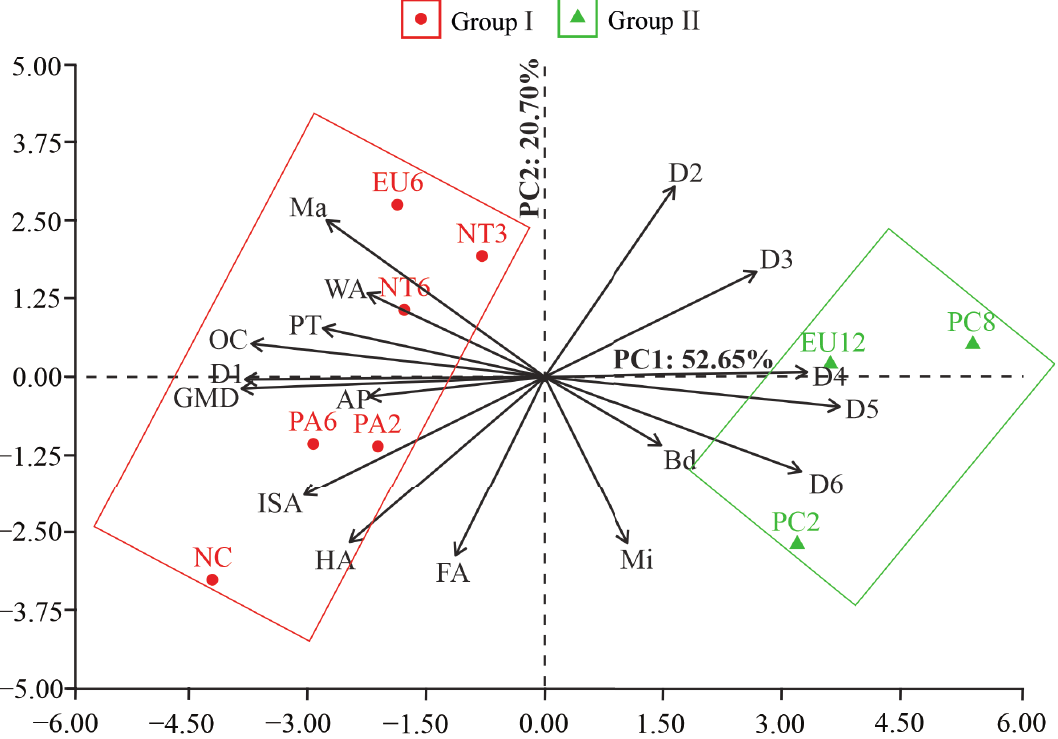
Figure 3. Analysis of variables main components related to physical characteristics in different management systems of Yellow Latosol. Group I: Native Cerrado (NC); No-tillage three years (NT3); No-tillage six years (NT6); Pasture two years (PA2); Pasture six years (PA6); Eucalyptus six (EU6). Group II: Twelve year Eucalyptus (EU12); conventional tillage two years (CT2); conventional tillage eight years (CT8). Variables: Total porosity (TP); Macropores (Ma); Micropores (Mi); Aeration porosity (AP); Bulk density (Bd); Geometric mean diameter (GMD); Index of stability of aggregates (ISA); Classes of aggregates: 8-2 (AG1), 2-1 (AG2), 1-0.5 (AG3), 0.5-0.25 (AG4), 0.25- 0.105 (AG5) and <0.105 mm (AG6) in diameter; Water available (WA) Organic carbon (OC); Fluvic acid (FA); Humic acid